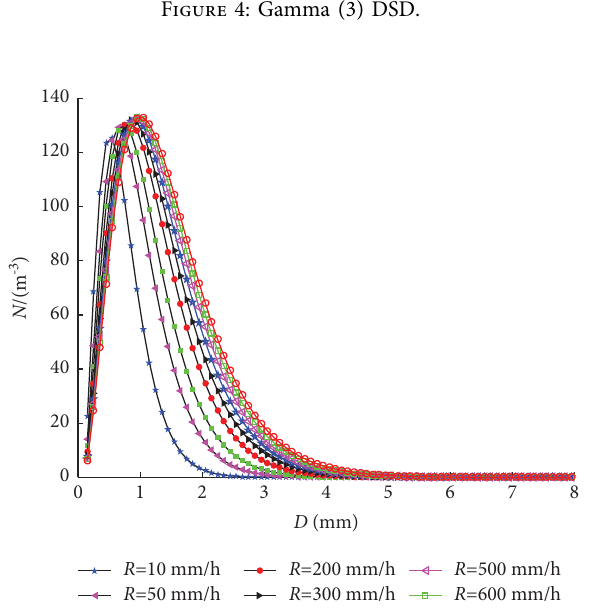
Figure 5: Number of raindrops in unit space.